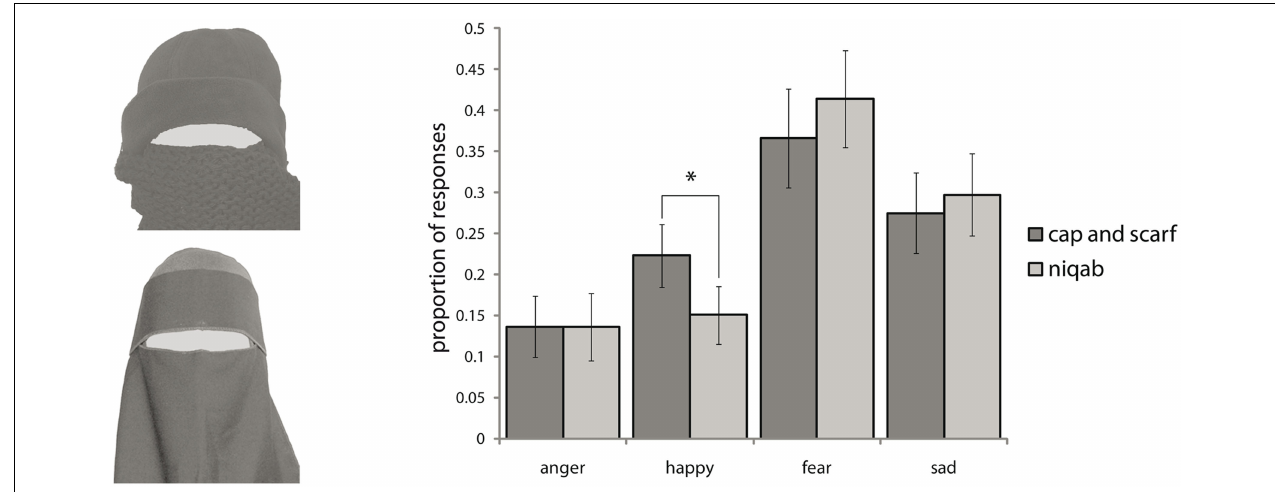
FIGURE 3 | Proportion of answers that were given to the headgear templates. A cap and scarf were more often associated with happiness than a niq ¯